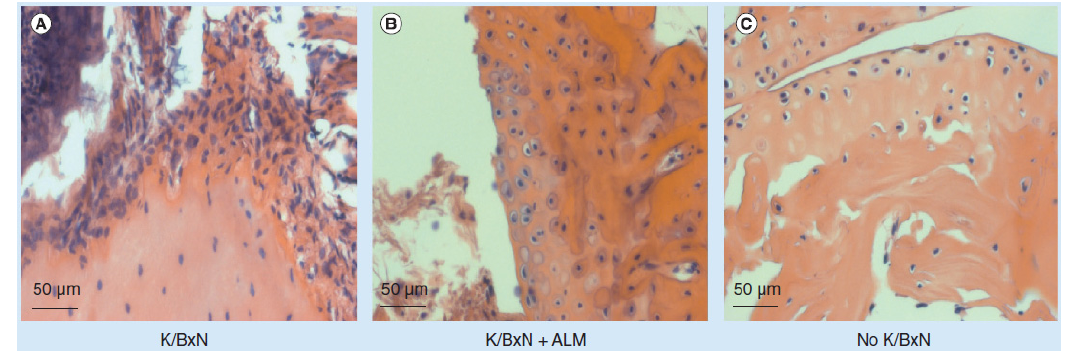
Figure 4. Fullerenes attenuate inflammatory arthritis of the K/BxN-induced disease pathology. ( A ) Serum-treated mice demonstrated typical synovial hyperplasia, pannus formation and inflammatory infiltrates; ( B ) By contrast, ALM-treated animals had less evidence of clinical joint inflammation compared with ( C ) non-diseased